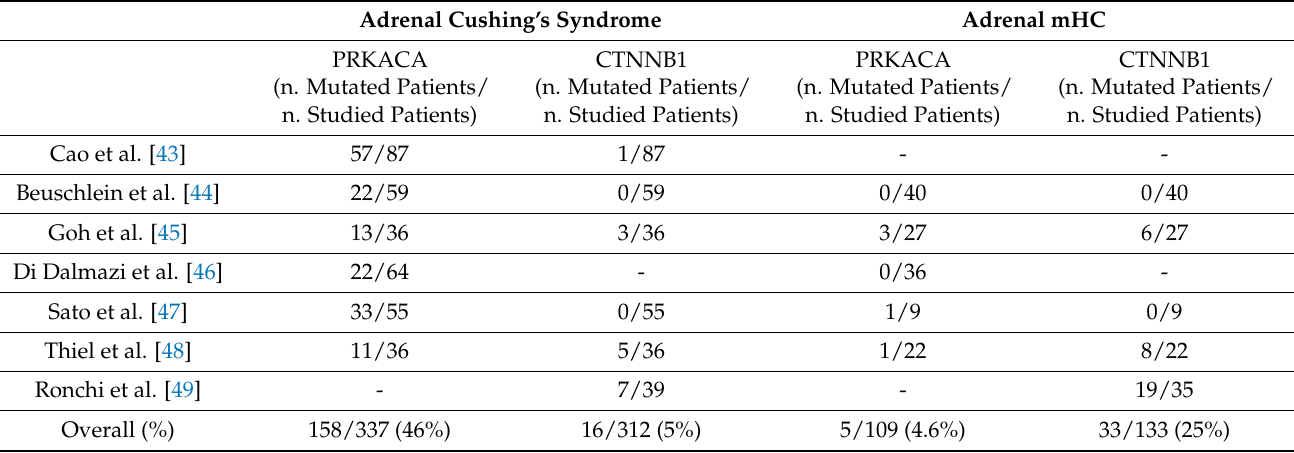
Table 3. Genetic alterations in unilateral adrenal adenomas associated with Cushing’s syndrome and mild hypercortisolism